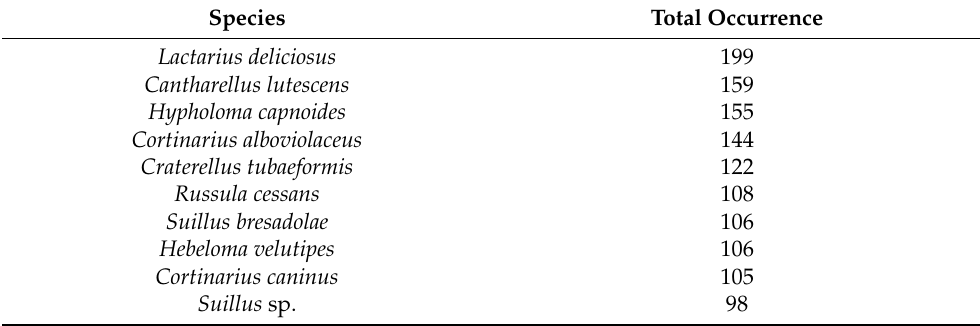
Table 3. List of the 10 macroscopic mushroom species most frequently found in the 238 subsamples of white-tailed deer feces collected on Anticosti Island (Quebec, Canada) in 2014 and